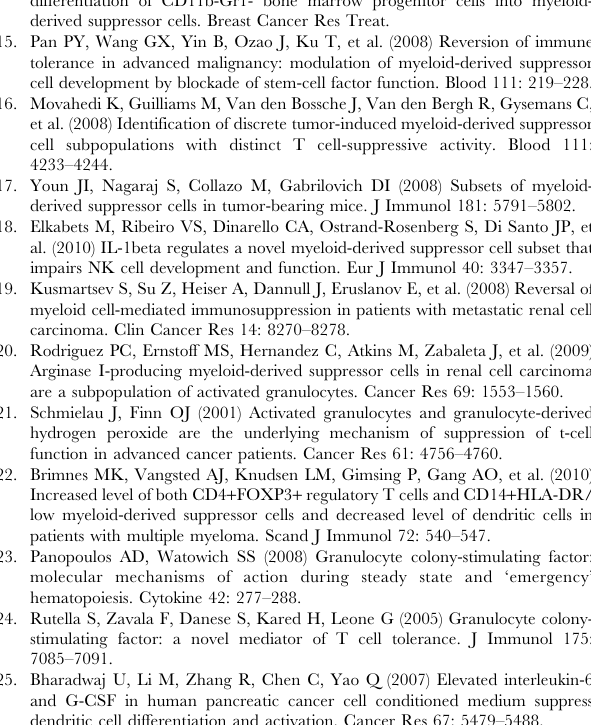
Figure S3 Impact of G-CSF knockdown on tumor growth in vitro , serum G-CSF levels and MDSC fre- quences in vivo. ( A ) Control and shRNA 1 AT-3 cells were measured for potential differences in proliferation in vitro by the MTS assay, a variation of the MTT assay. Tumor cell lines were incubated in flat-bottomed, 96-well plate for 24 hr at multiple cell densities. After incubation time, the MTS solution was added and the extent of proliferation was determined by measuring OD at 490 nm. ( B ) Stability of G-CSF knockdown in vivo was determined by measuring systemic G-CSF levels from both groups of mice with comparable tumor volumes (800 – 1000 mm 3 ). Data at comparable tumor volumes, and analyzed for the percentages of granulocytic and monocytic subsets. G-CSF knockdown in AT-3 cells led to a significant decline in granulocytic MDSC. Data Figure S4 Impact of G-CSF over-expression on tumor growth in vitro , serum G-CSF levels and MDSC fre- quences in vivo . ( A ) CMS4-vector control (CMS4-VC) and G- CSF-producing CMS4 cells (CMS4-GCSF) were measured for potential differences in proliferation in vitro as in Fig. S3. Data expressed as the mean OD (at 490 nm) 6 SEM (n= 3). ( B ) Each cell line was also analyzed for G-CSF receptor expression by flow cytometry. One of 3 representative experiments is shown. ( C ) Stability of G-CSF over-expression in vivo was determined by measuring systemic G-CSF levels from the two groups of mice with equivalent tumor volumes ( , 1000 mm 3 ). Data expressed as the mean 6 SEM (n= 5; P , 0.0001). ( D ) Photograph of representative spleens from CMS4-VC or CMS4-GCSF tumor bearing mice ( , 1000 mm 3 ). ( E ) Splenocytes in D were isolated from mice bearing CMS4-VC or CMS4-G tumors, and analyzed